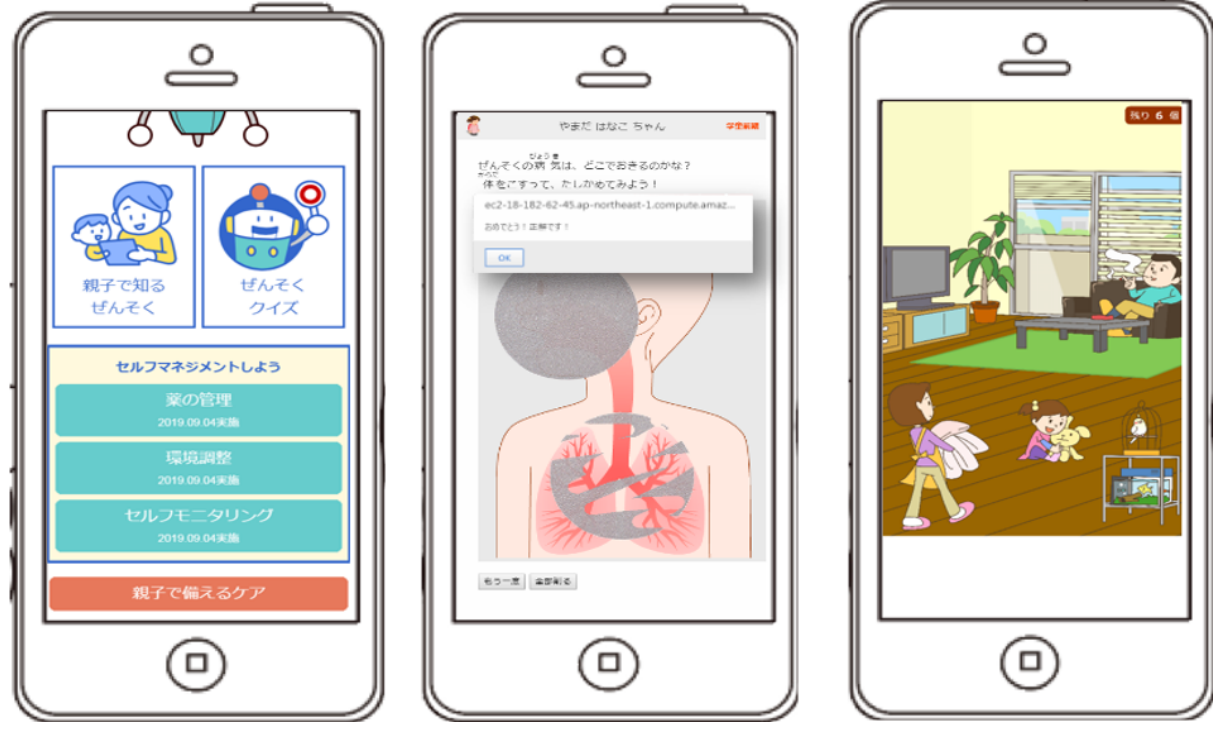
Figure 2. Examples of features for children <7 years old with asthma and caregivers: main home screen (left) and asthma pictorial book with scratch and search for asthma deterioration factors (middle and